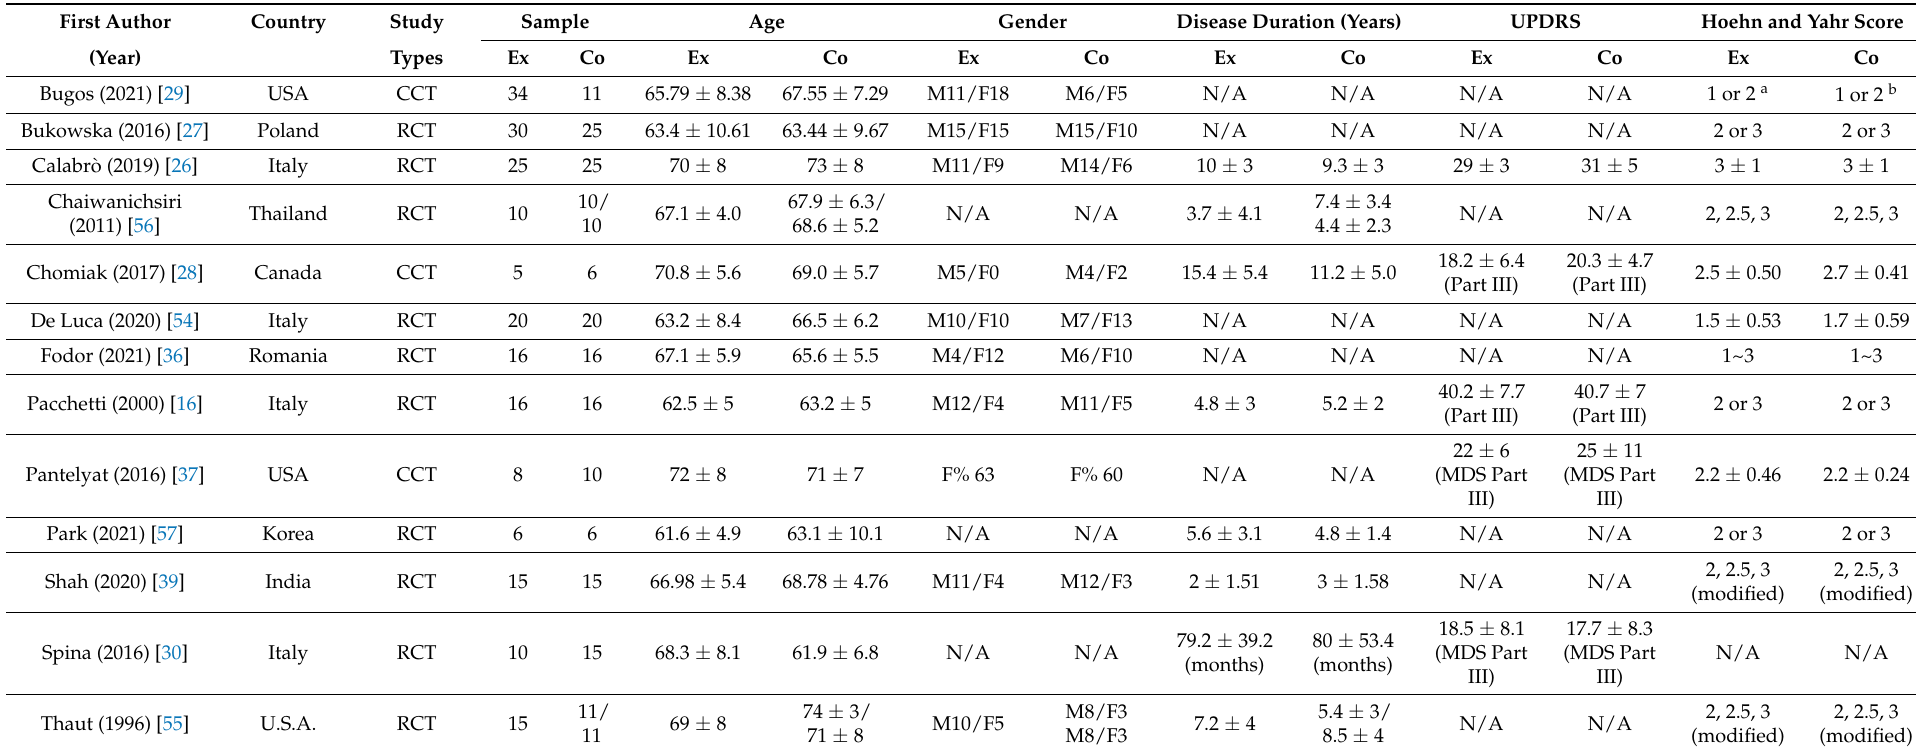
Table 1. Characteristics of